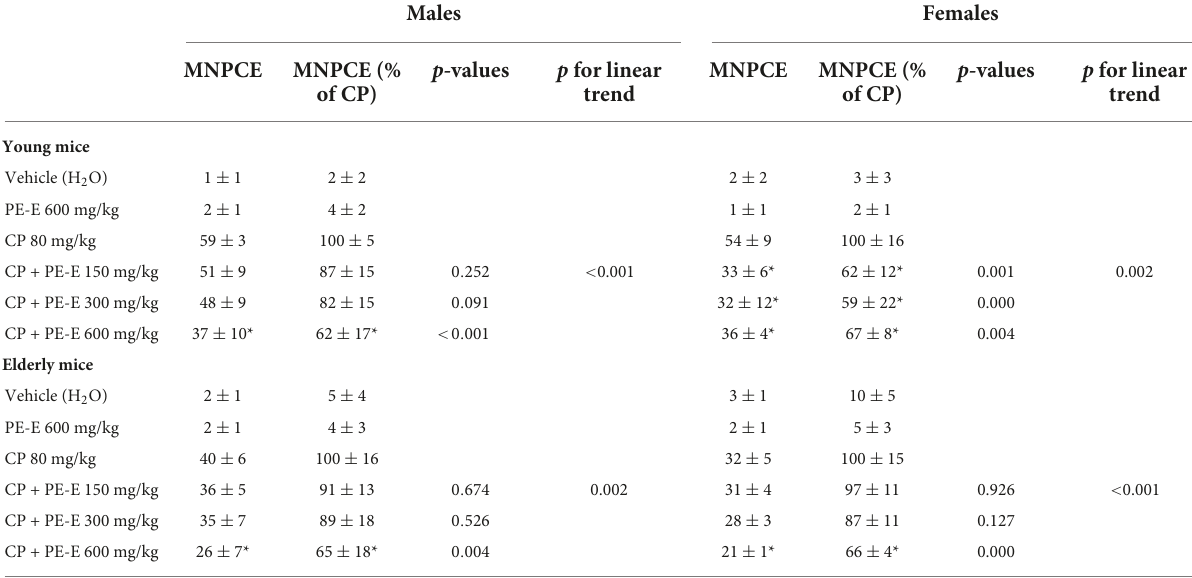
TABLE 1 Number of micronucleated polychromatic erythrocytes (MNPCEs) per 1,000 polychromatic erythrocytes (PCEs) in bone